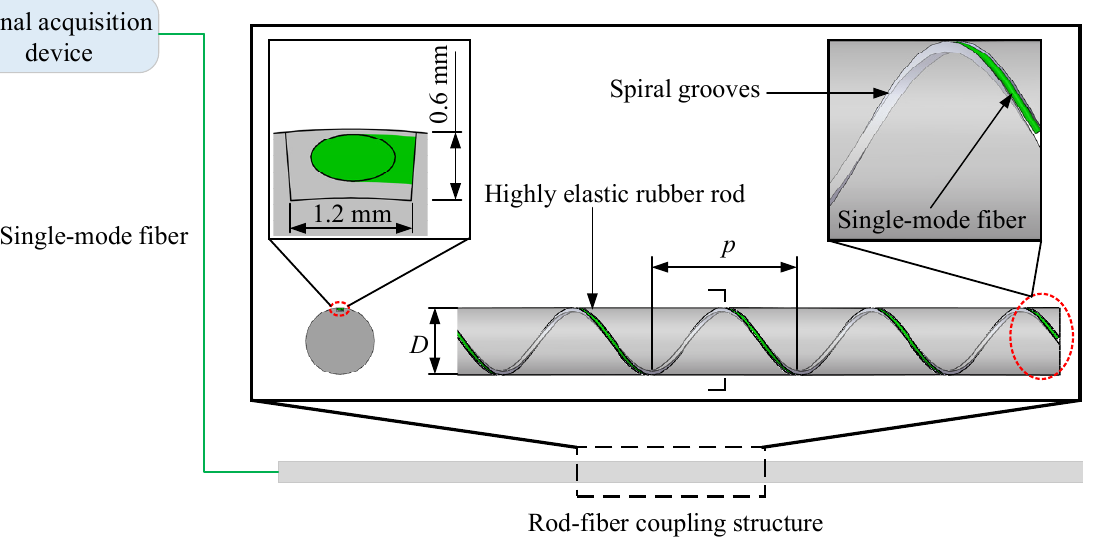
Figure 1. Structural diagram of rod-fiber coupling structure ( D is the diameter of the highly elastic rubber rod, and p is the pitch of the spiral